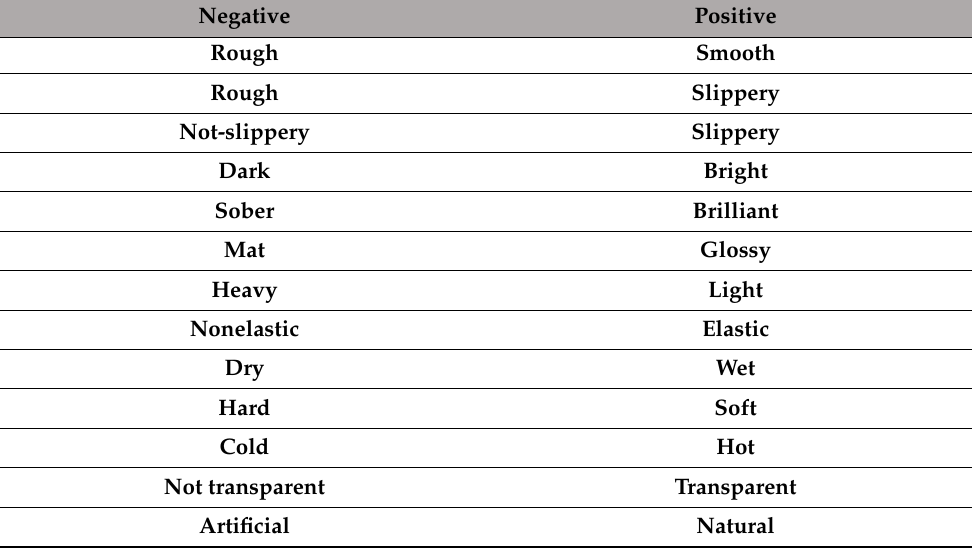
Table 2. Adjective pairs used in the evaluation.